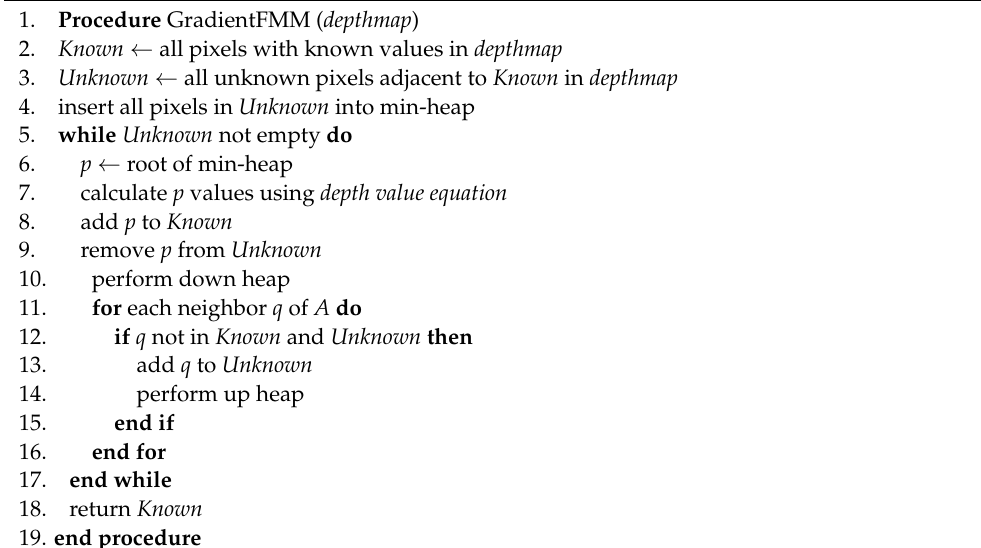
Algorithm 1: Gradient Fast-Marching Method (GradientFMM)